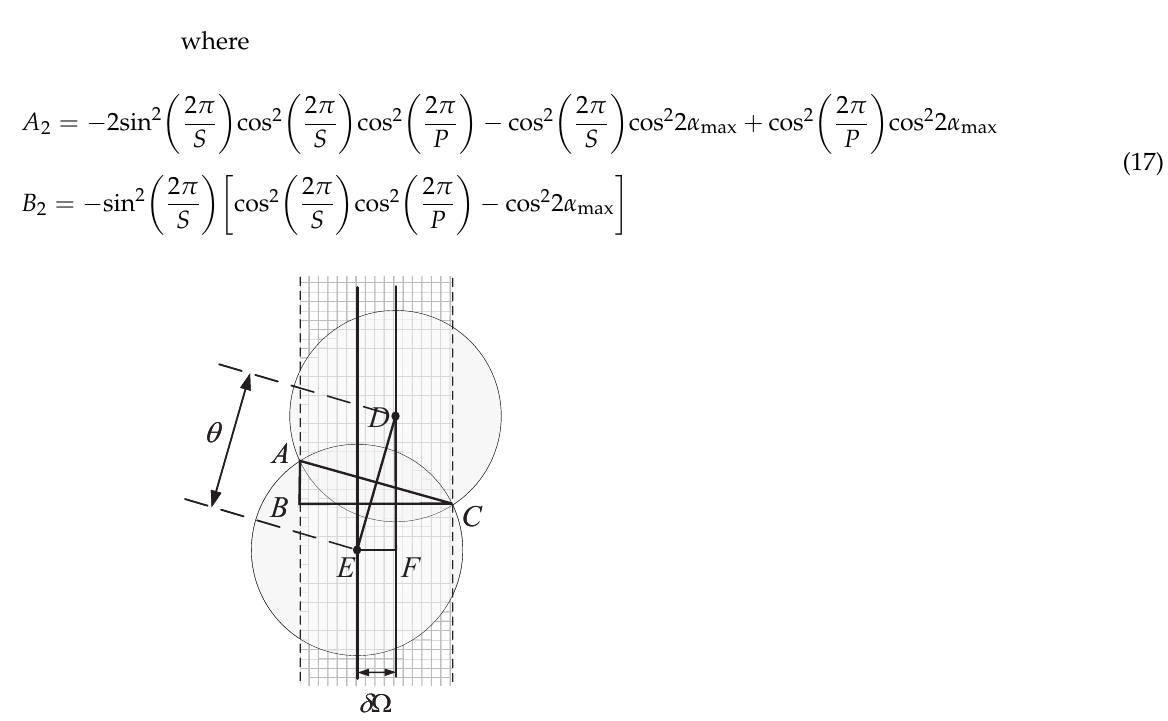
Figure 4. Street-of-coverage geometry of the perturbed coplanar satellites. D and E are two sub- satellite points. A and C are two intersections of two coverage circle. Point A, B, C form a right triangle. Point D, E, F form a right